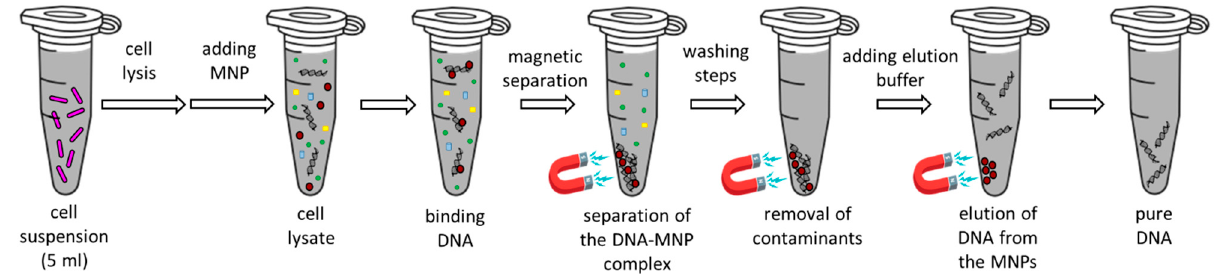
Figure 8. pDNA isolation with MnFe 2 O 4 magnetic nanoparticles.